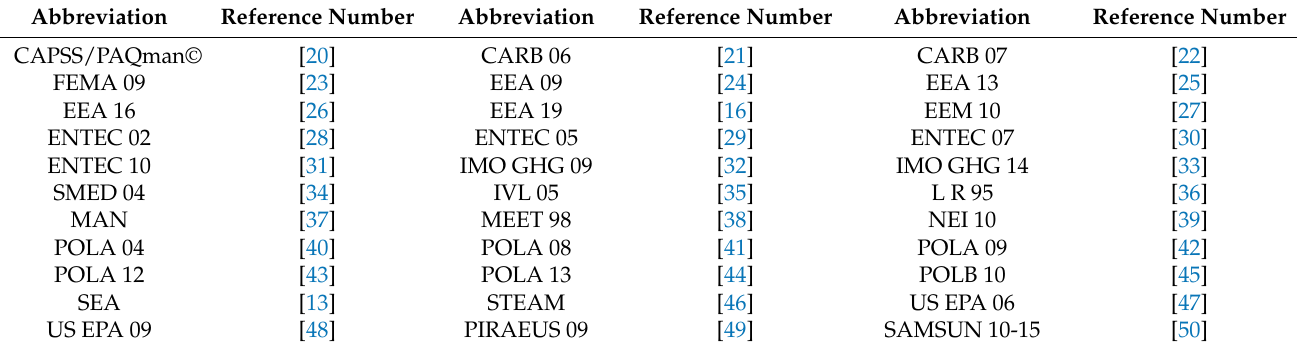
Table 1. Abbreviations of cited studies and papers with their reference